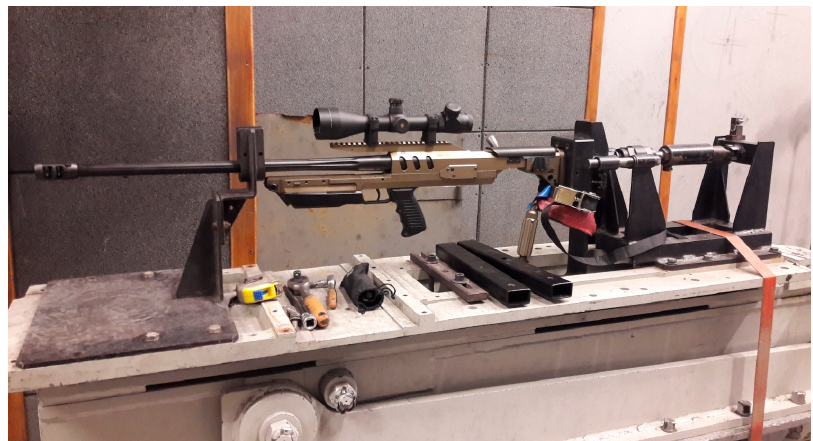
Figure 3. Stand for shooting samples.